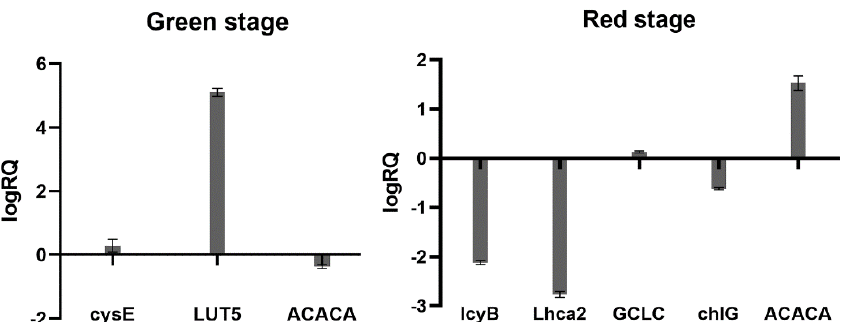
Figure 12. Real-time quantitative PCR verification results, the left side is the gene in the green stage, the right side is the gene in the red stage, the abscissa is the gene name, logRQ > 0 means the gene is upregulated, and logRQ < 0 means the gene is downregulated.